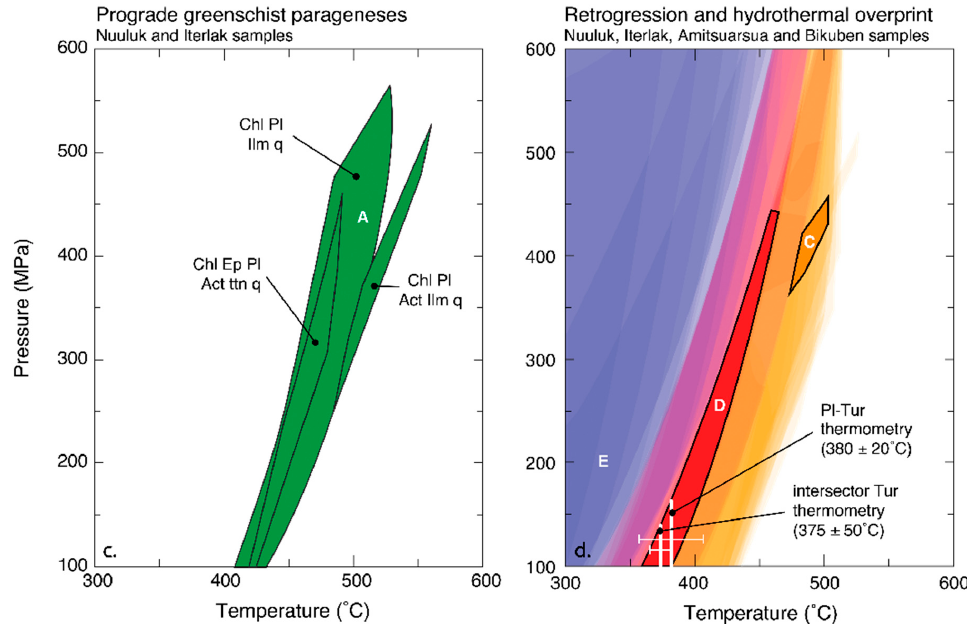
Figure 4. Pseudosection results for Tartoq greenschist assemblages; ( a ) Typical retrograde Nuuluk greenschist with peak conditions in the amphibolite field B as defined by mineral relics and progressive retrograde assemblages from field C to E ; ( b ) Prograde Nuuluk greenschist (field A) with peak paragenesis at B; ( c ) Pseudosection fields for all prograde greenschist-facies parageneses from Nuuluk and Iterlak; ( d ) P–T constraints for successive retrograde assemblages from overlapping pseudosection for all retrograde assemblages compared to tourmaline thermometry results. Minerals starting with a capital letter were modelled as a solid solution. Mineral abbreviations as in Figure 3 and carb = carbonate.